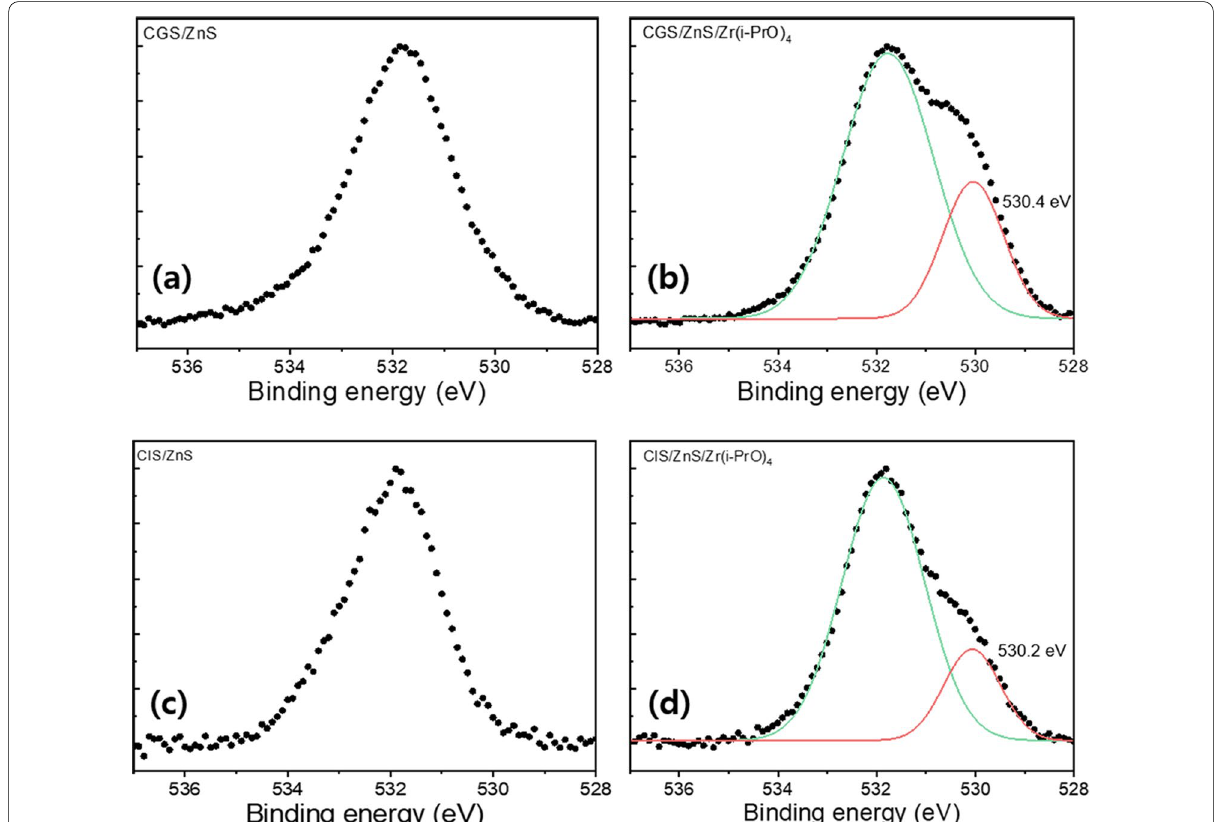
Fig. 3 Partial XPS survey results of O component peaks of green a CGS/ZnS and b CGS/ZnS/Zr(i-PrO) 4 QDs; and red c CIS/ZnS and d CIS/ZnS/ Zr(i-PrO) 4 QDs. In the XPS spectra, ZrO 2 (red line) peak is deconvoluted from the original O spectra (black